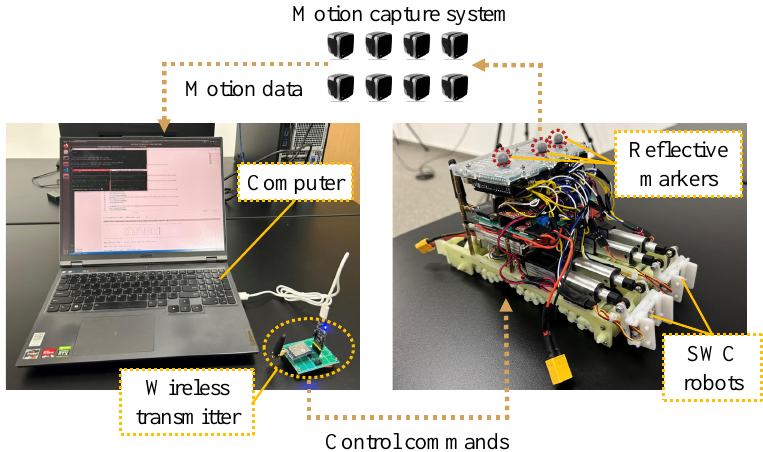
Figure 7. The SWC robotic system with wireless data transmission.